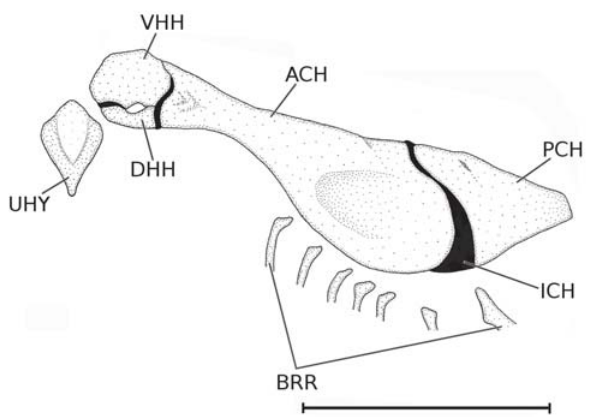
Fig. 9. Hyoid arch of Leptodoras oyakawai , based on MZUSP 95722, 73 mm SL, in ventral view. ACH anterior ceratohyal, BRR branchiostegal rays, DHH dorsal hypohyal, ICH interceratohyal cartilage, PCH posterior ceratohyal, UHY urohyal, VHH ventral hypohyal. Scale bar 5 mm.